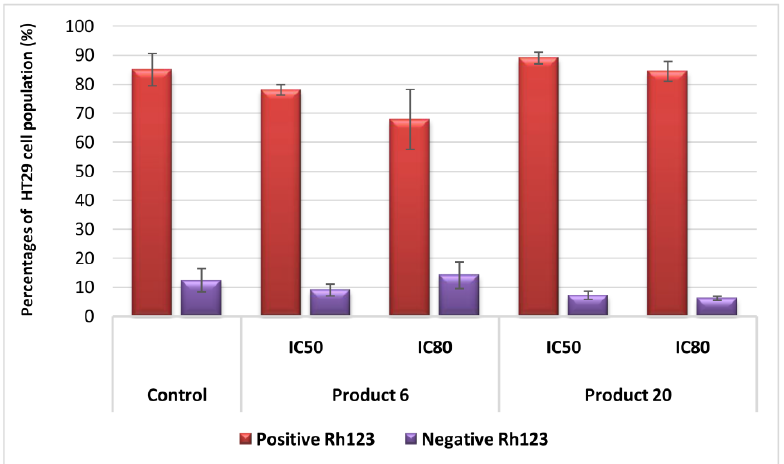
Figure 6. Effects of products 6 and 20 on mitochondrial membrane potential in colon adenocarcinoma HT29 cells, after 72 h treatment, at IC 50 and IC 80 concentrations. Percentage of HT29 Rh123 positive or negative cells, relative to untreated control cells (control). Values are expressed as the mean ± SD of two independent experiments, performed in triplicate.